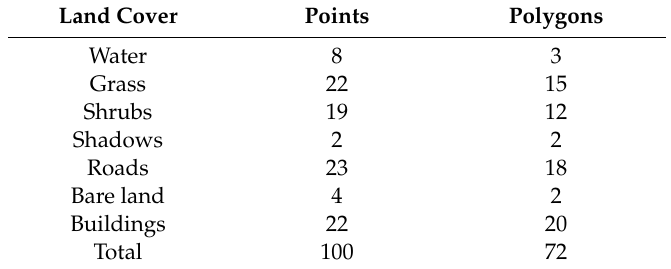
Table 3. Number of samples per class for training and test set for the two data